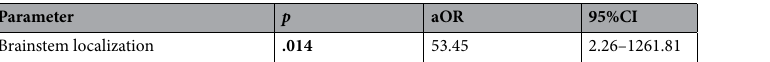
Table 2. Logistic regression analysis adjusted for age and sex assessing baseline characteristics and risk of postoperative deterioration. A minimum one-point increase on the mRS score compared to the preoperative score was defined as deterioration. Changes in mRS refer to comparison between mRS at admission and final follow-up. P values marked with bold indicate statistically significant differences between the groups.